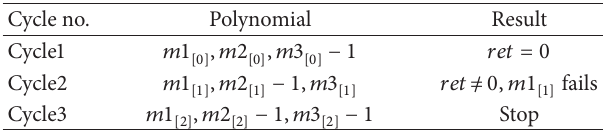
Table 1: Polynomial representations for properties to be verified. Table 2: Result table.